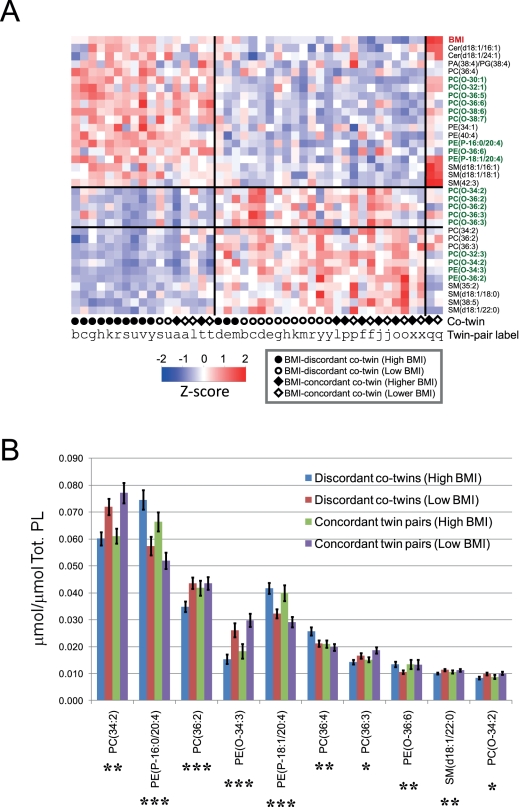
Adipose tissue lipidome in acquired obesity.Lipidomic analysis covered 314 molecular lipids in adipose tissue
biopsies from 44 subjects (13 twin pairs discordant for BMI, nine twin
pairs concordant for BMI). Thirty-four lipids were differentially
regulated when comparing obese and lean weight-discordant twins (FDR
q<0.05). (A) Lipidomic profiles of the 34
differentially regulated lipids in acquired obesity, shown for all
subjects included in the study. The detected ether phospholipids are
marked in green. The twin status for each subject is shown at the
bottom. (B) Concentration, shown as fraction of the total phospholipid
concentration as measured by lipidomics (Tot. PL), of the 11 most
abundant differentially regulated lipids from (A), shown separately
across the four groups corresponding to lean and heavy twins discordant
for BMI, and the concordant twin pairs divided into two groups: high BMI
(BMI≥25 kg/m2) and low BMI (BMI<25 kg/m2).
p-Values are shown for pairwise t
test comparison of discordant twins. *, p<0.05;
**, p<0.01; ***,
p<0.001. Error bars are ± SEM. SM,
sphingomyelin.